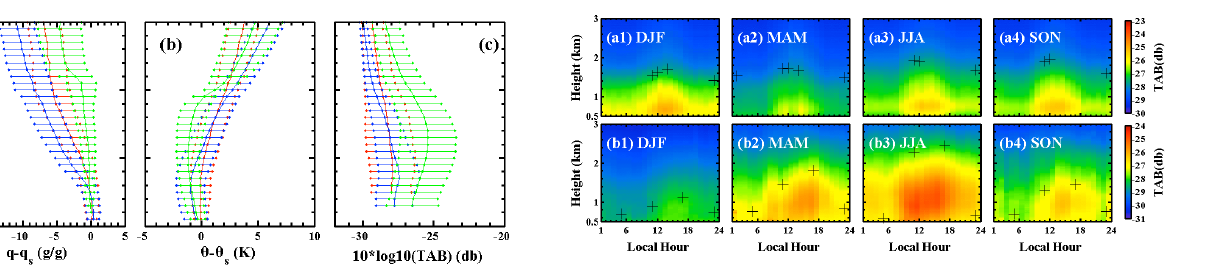
Figure 2. Comparison of the ABL structure in terms of the mean and the standard deviation of mixing ratio (a), potential temperature (b) and TAB (c) from 2-year (2007-2008) oceanic measurements and 3-year (2007-2009) continental measurements. The height is normalized by the SONDE-derived BLH. The green and blue line denotes the